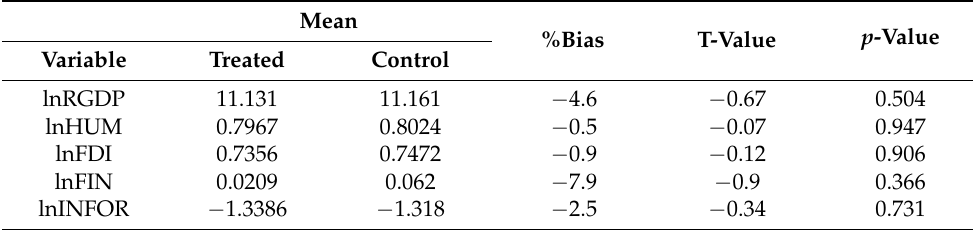
Table 3. Applicability test of the PSM-DID